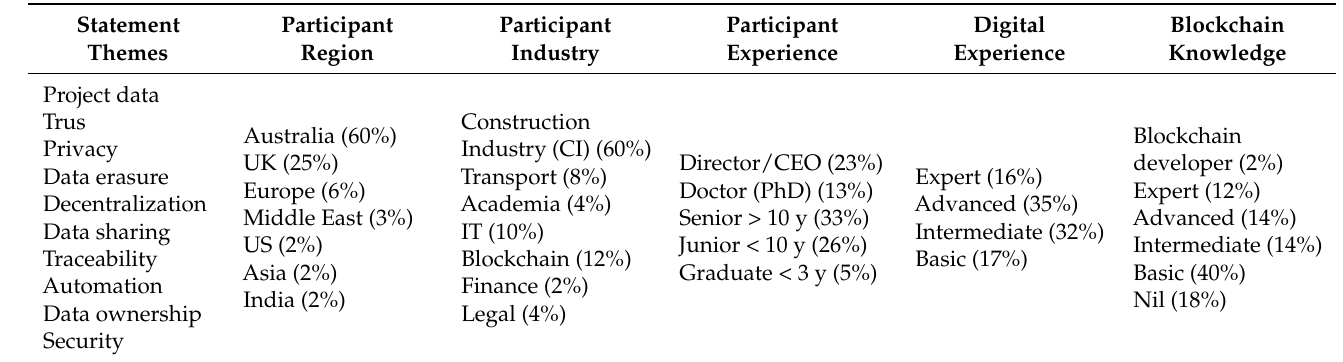
Table 2. Summary of the survey statement themes and the data profile including regions, roles, and